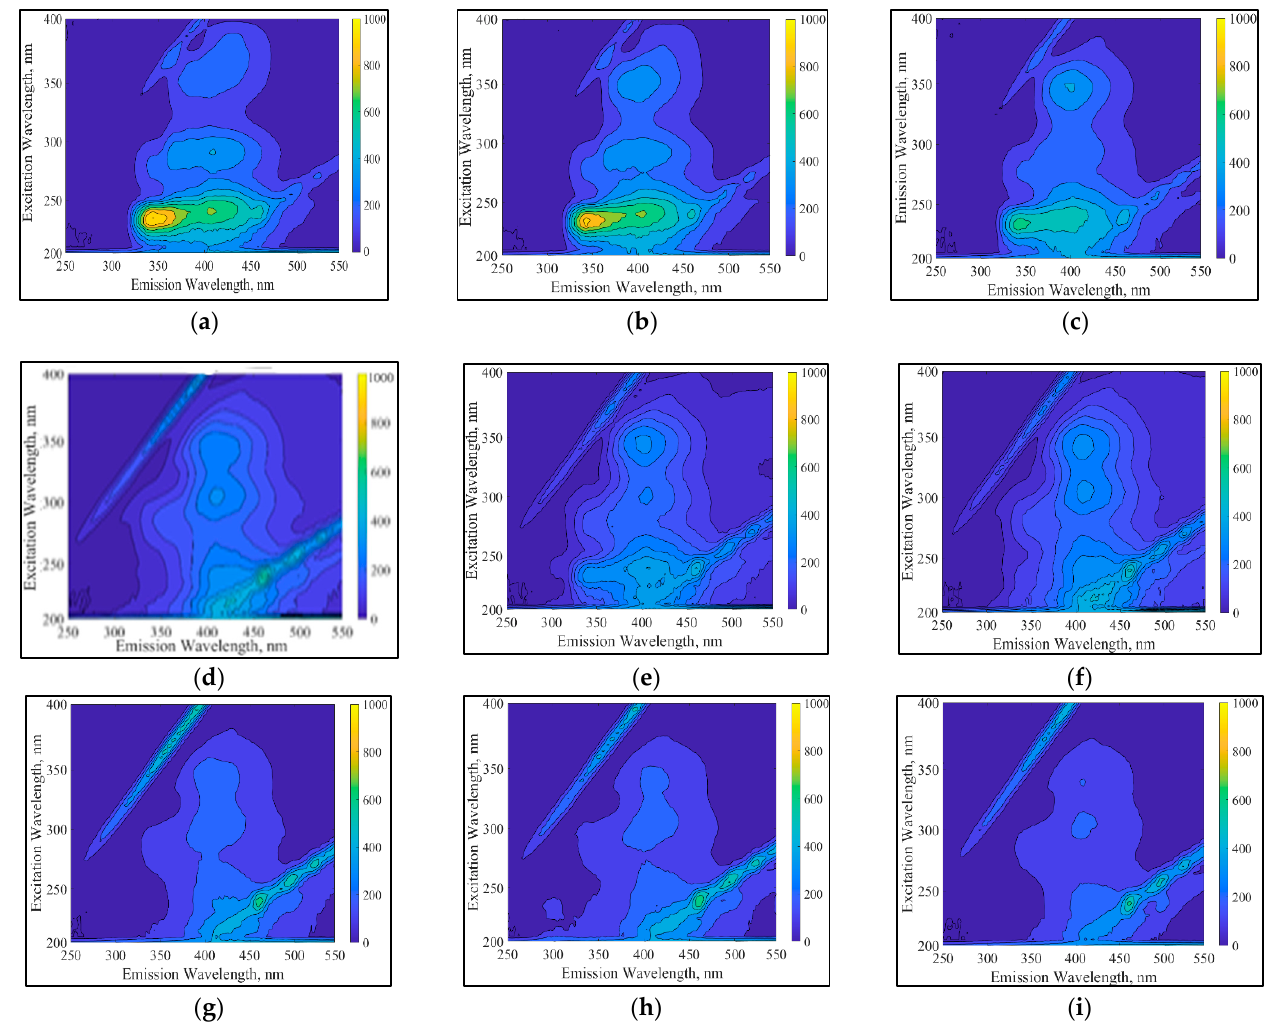
Figure 4. EEM fluorescence contour plots of RB5 at different irradiation times: ( a ) t irr : 0 min; ( b ) t irr : 5 min; ( c ) t irr : 15 min; ( d ) t irr : 30 min; ( e ) t irr : 60 min; ( f ) t irr : 120 min; ( g ) t irr : 180 min; ( h ) t irr : 210 min; ( i ) t irr : 240 min. Experimental conditions: RB5 = 20 mg/L; pH = 3; LF = 0.5 g/L; I 0 = 0.5 W/L (UV-A).